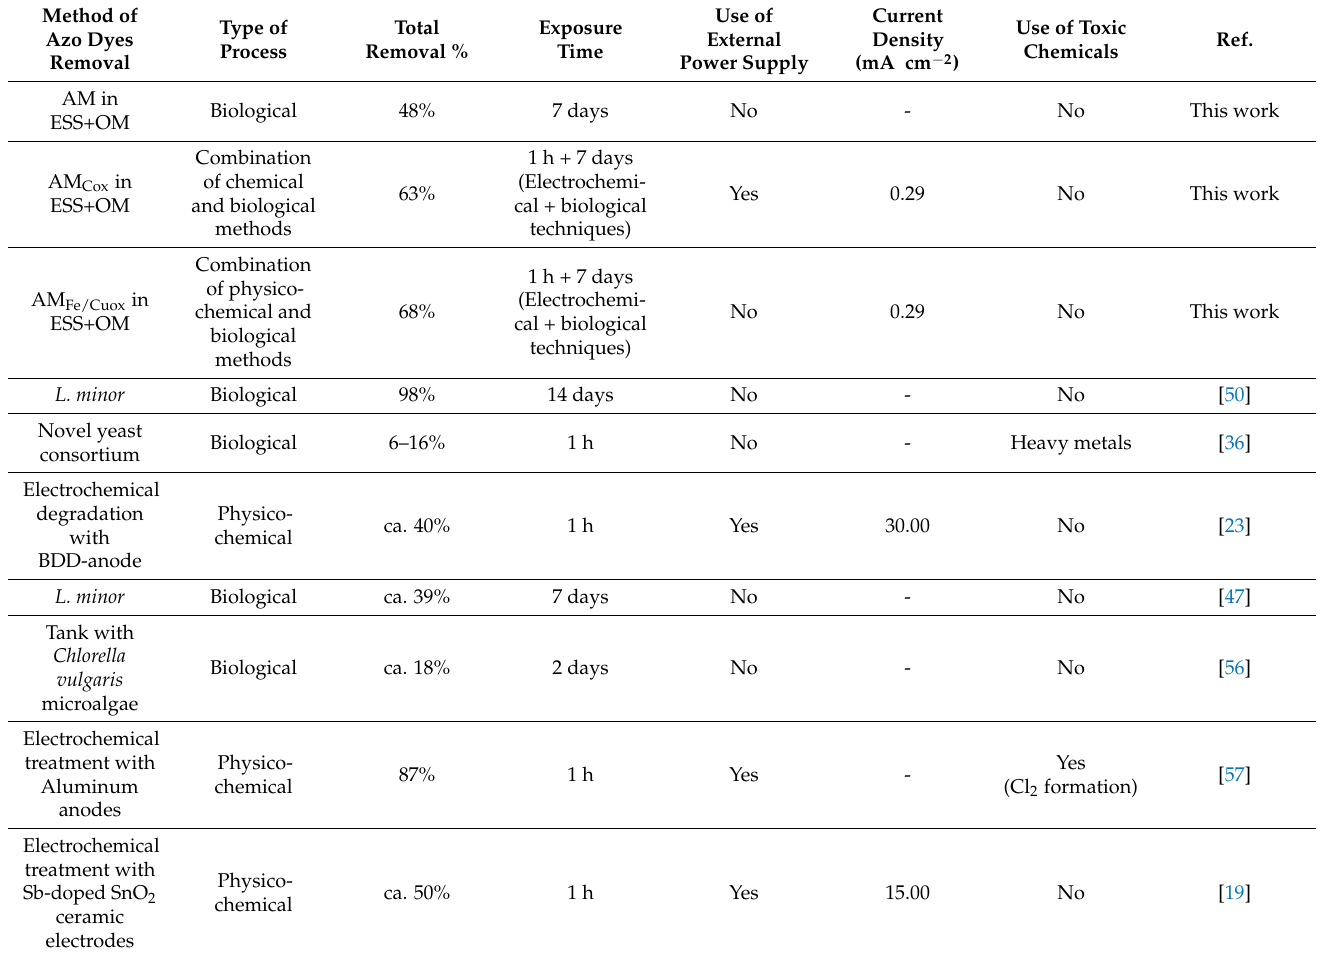
Table 7. Comparison of various novel azo dyes removal